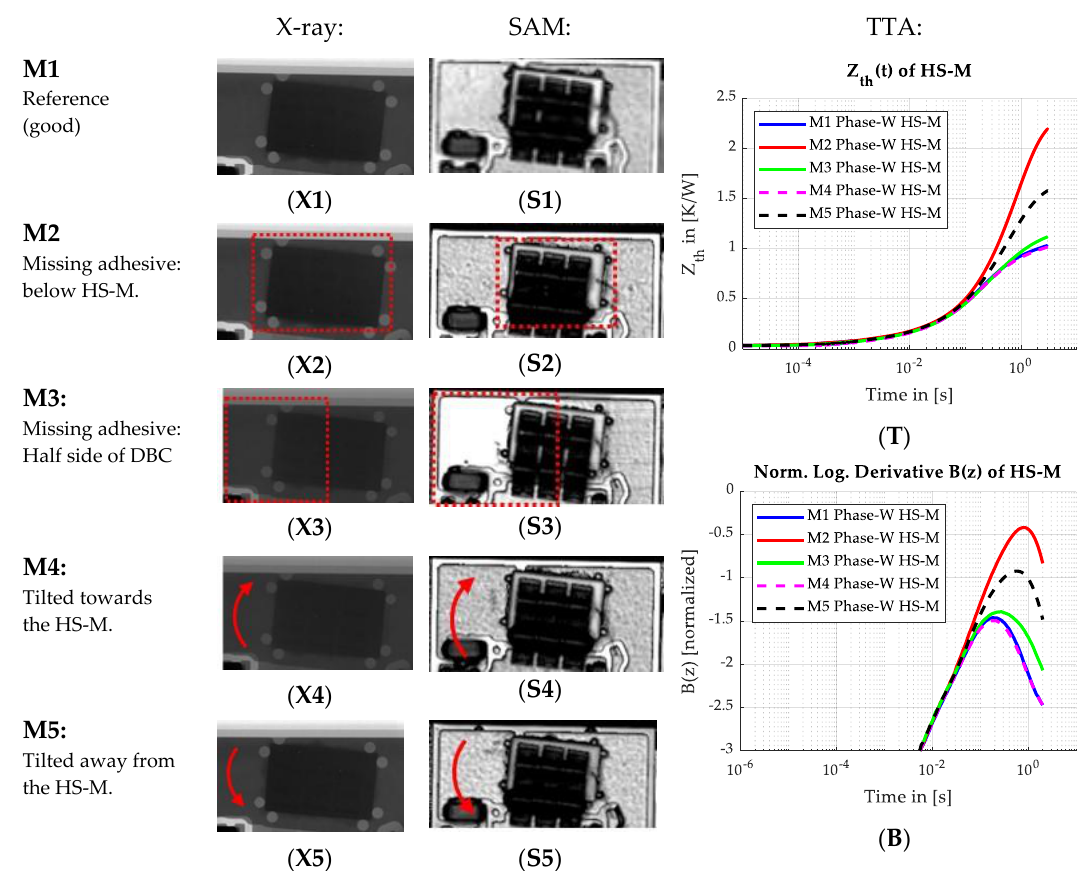
Figure 10. Comparison of NDTs on adhesive interconnects. ( X1 ) to ( X5 ) show X-ray images of one high-side MOSFET (HS-M) of each module and ( S1 ) to ( S5 ) show the SAM image with a 30 MHz transducer from the same HS-M. Markings of the manipulation types are included. The Z th (t) of these HS-Ms are plotted in ( T ) normalized to the reference M1 and the normalized logarithmic derivative in ( B ), with a normalization interval between 0.1 ms and 1 ms, and measured peak increases compared to M1 of 1.04 for M2, 0.68 for M3, − 0.037 for M4, and 0.54 for M5 were